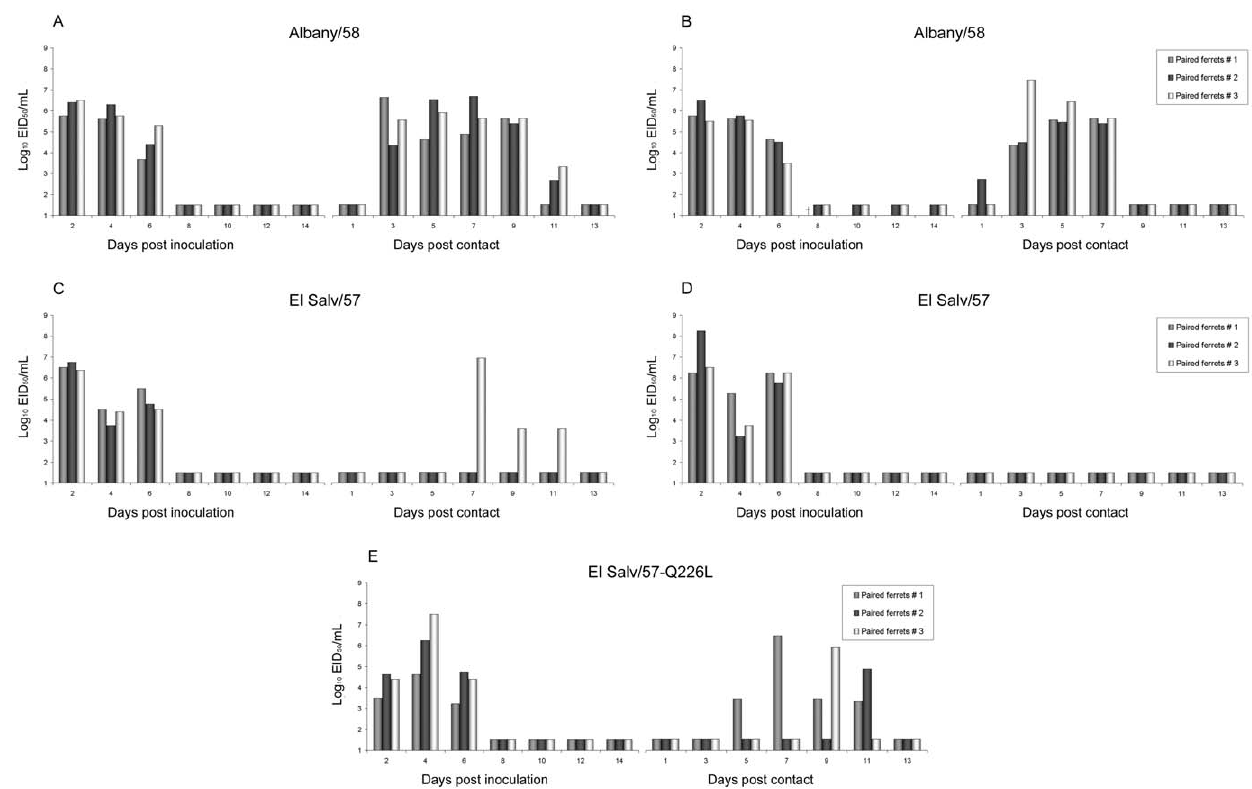
Figure 2. Respiratory droplet and direct contact transmission experiments using human H2N2 viruses. For each experiment, three ferrets were inoculated i.n. with 10 6 EID 50 of Albany/58, El Salv/57 or El Salv/57-Q226L mutant. Each ferret was placed in individual cages. A, C and E : Twenty four hours later, one naı¨ve ferret was housed in a cage adjacent to each of the cages containing an inoculated ferret (respiratory droplet transmission), separated by perforated walls to allow the exchange of respiratory droplets. B and D : For direct transmission experiments, one naı¨ve ferret was housed in the same cage with the inoculated ferret. Nasal wash samples were collected from the inoculated and contact ferrets on alternating days and titered by EID 50 . Bars with the same color represent an inoculated/contact ferret pair. The limit of virus detection was 10 1.5 EID 50 / ml. { , ferret found dead on day 8 p.i.